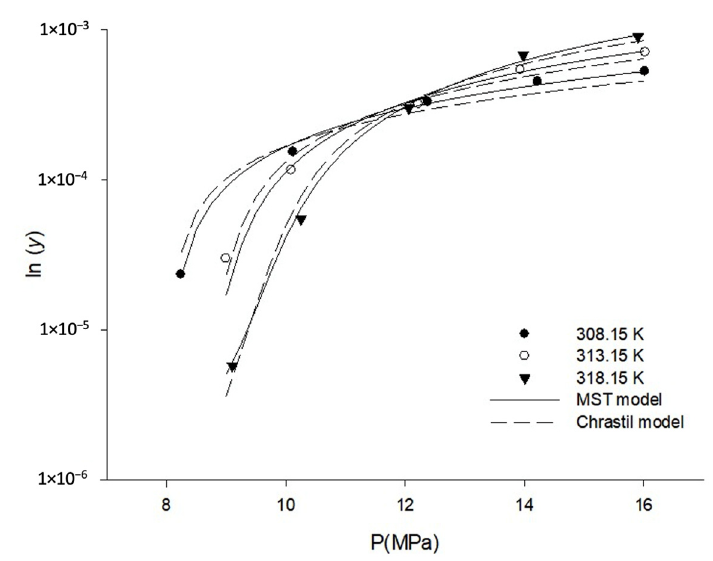
Figure 3. The solubility (mean value, n = 3) of orlistat in SC-CO 2 at various pressure and temperature, measured experimentally and predicted using the two semi-empirical models (Chrastil model and the Mendez-Santiago and Teja (MST) model) to correlate experimental solubility data.